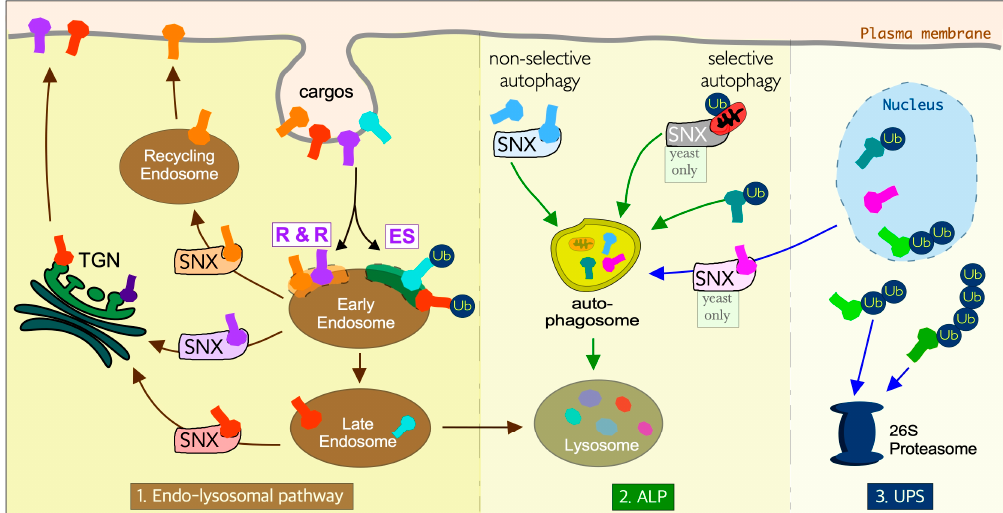
Figure 1. Sorting nexins and ubiquitin coordinate the three distinct but interconnected protein proteolysis pathways. In the endo-lysosomal pathway, membrane proteins are sorted at the early endosome. Cargos destined for lysosomal degradation are marked by ubiquitination and internalized using endosomal sorting complexes required for transport pathways (ES). Cargos destined for recycling are retrieved either by the retromer or retrieval complex (R & R) coupled with various subclasses of sorting nexins (SNX- see text for details). In the autophagy-lysosome pathway (ALP) cargos are sequestered to the vacuole by double-membraned vesicles called autophagosomes by selective or non-selective mechanisms. Selective pathways in yeast are mediated by SNX-Bar heterodimers. In mammalian cells, the recognition of selective autophagy cargos is dependent upon ubiquitination (Ub). The ubiquitin-proteasomal system (UPS) targets short-lived regulatory proteins that are selectively targeted and degraded. TGN- trans -Golgi network, SNX-sorting nexin. In cells, the TGN and nucleus are in close proximity, whereas here they are drawn apart for